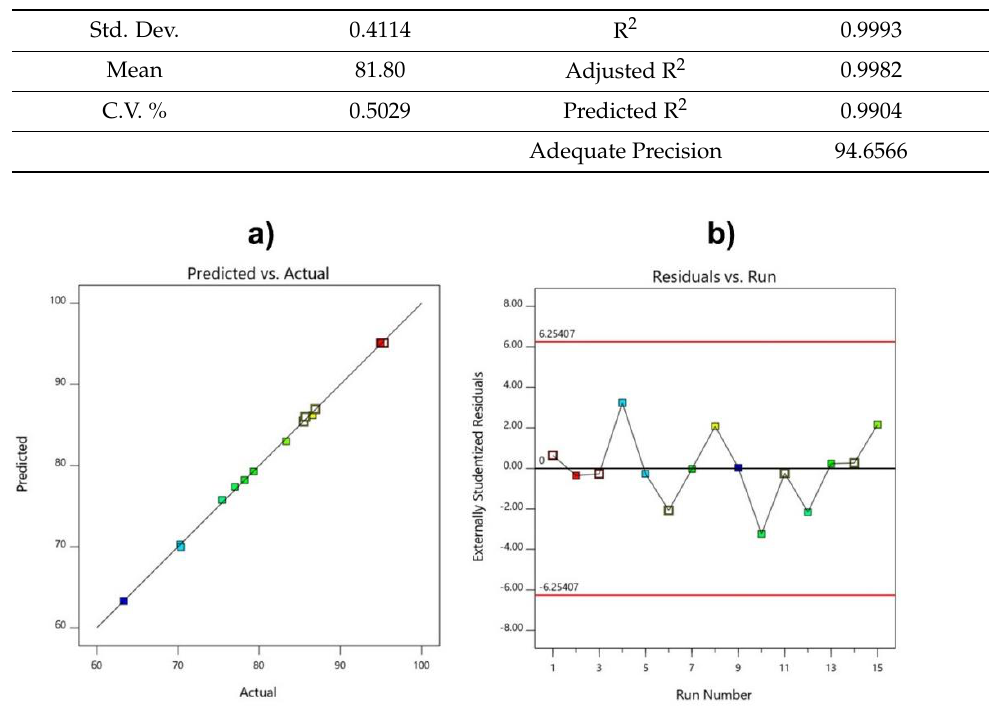
Table 5. Results of the analysis of the suitability of the experimental model.